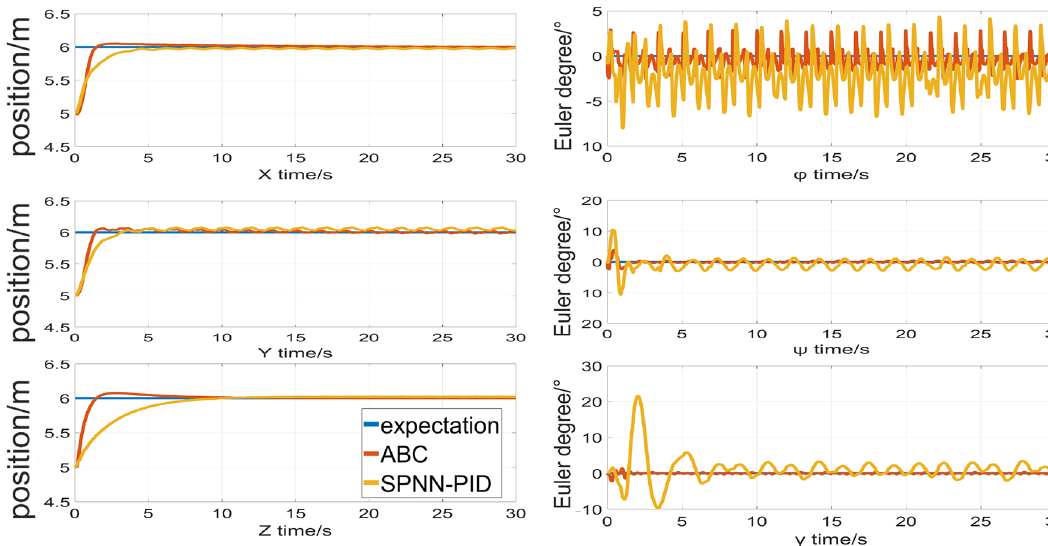
Figure 9. Responses in positions and attitudes for Virtual Experiments.